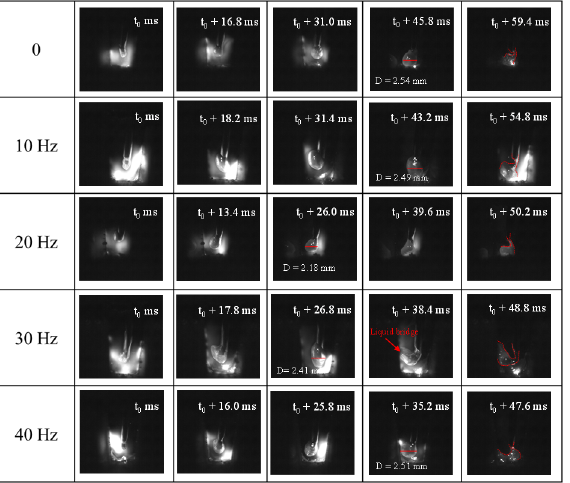
Figure 10. Droplet transfer process at 16 mT with different magnetic frequency.